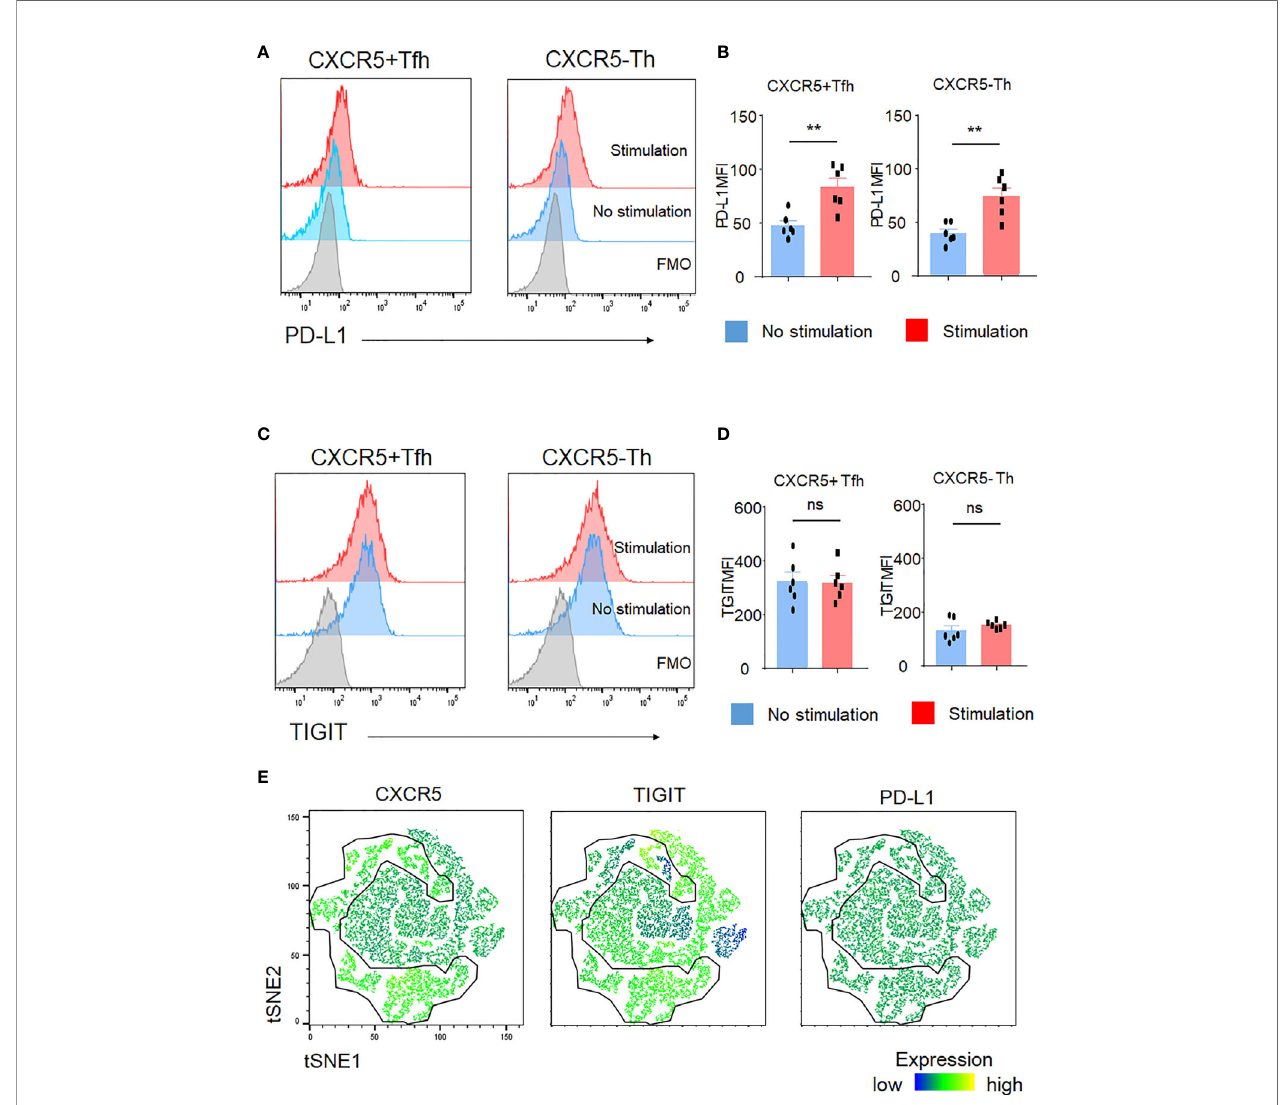
FIGURE 4 | TIGIT is not an activation marker. (A – D) CD4 + T cells were stimulated for 4 hours with phorbol myristoyl acetate and ionomycin. Surface expression of PD-L1 and TIGIT in Tfh cells or Th cells was measured by fl ow cytometry. (A, C) , representative image. (B, D) , multiple comparison results (n=6). FMO, Fluorescence minus one control. (E) Stimulated single cell was plotted by tSNE and expression levels of labeled markers (CXCR5, TIGIT, and PD-L1) are shown as a heatmap. (B, D) paired t-test. **p<0.01, ns